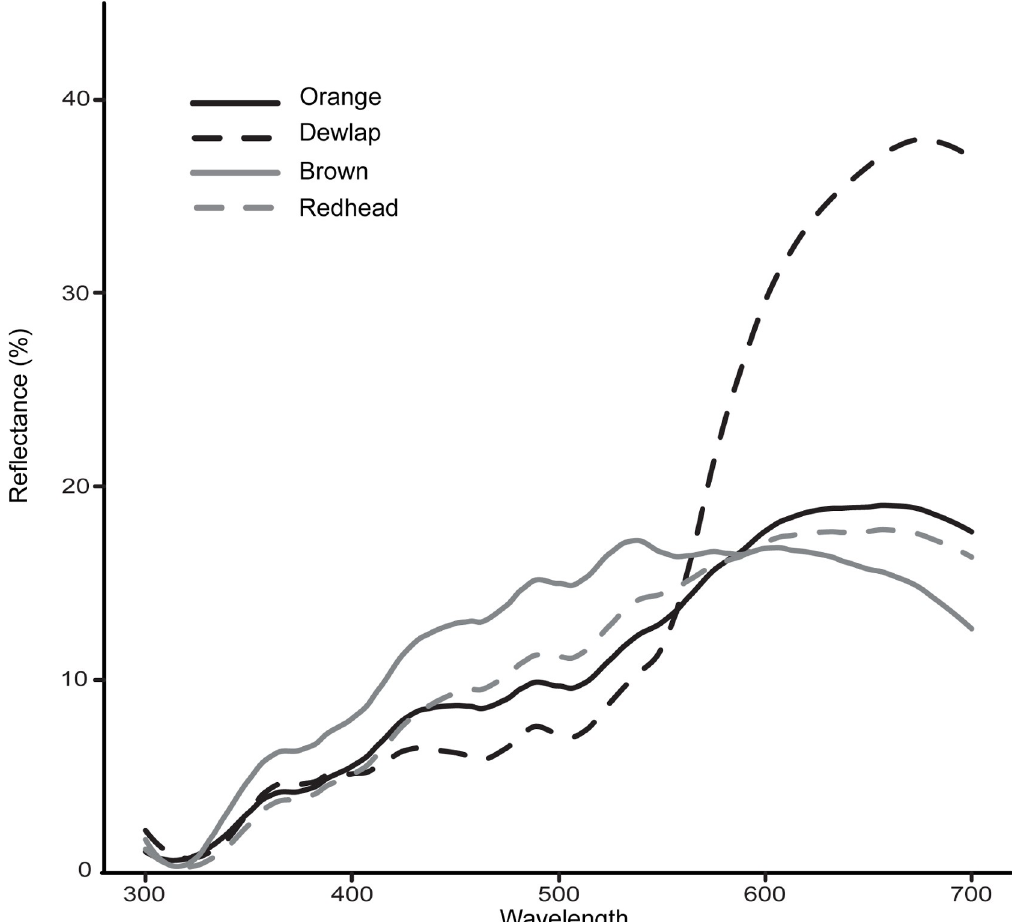
lizards differed significantly in their red chroma, and thus, their pigment concentration. Orange and redhead patches did not differ significantly in red chroma and may thus have similar pigment concentrations. Reflectance curves were smoothed for presentation after all statistical analyses were